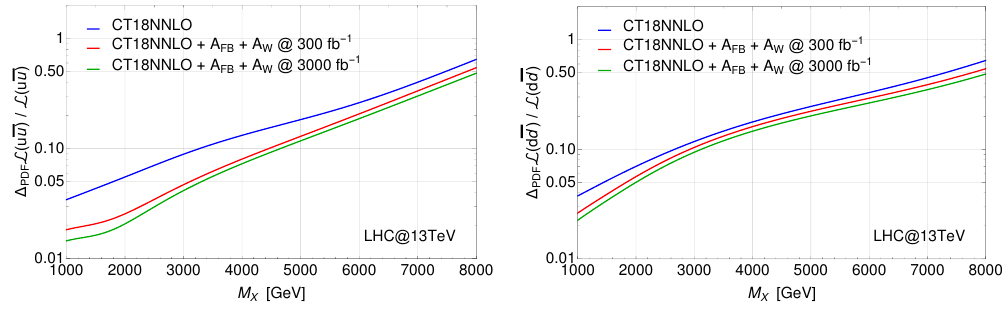
Figure 1 . Relative PDF error on the u ¯ u (left) and d ¯ d (right) parton luminosities, for the baseline CT18NNLO PDF set (blue) and the “improved” sets profiled using A FB and A W pseudodata with statistical uncertainty corresponding to 300 fb − 1 (red) and 3000 fb − 1